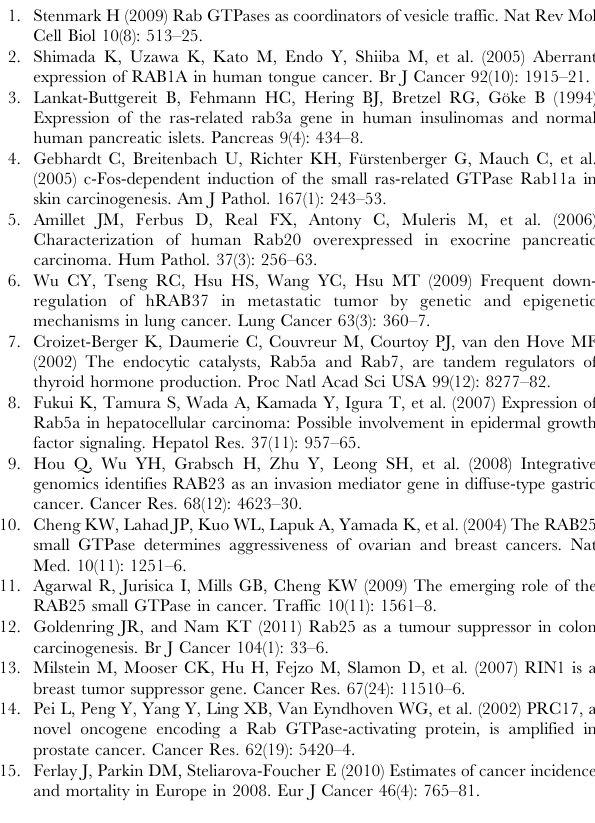
( FGFR3 -mutated) tumor samples and 63 T2–4 ( FGFR3 -non- mutated) tumor samples. Are highlighted (red corresponds to a correlation, green corresponds to an inverse correlation) when the two correlation values pass the thresholds: |r| . 0.479 (pValue , 1%) for the Ta G1G2 ( FGFR3 -mutated) group (28 samples) and |r| . 0.323 (pValue , 1%) for the T2–4 ( FGFR3 -non-mutated) group (63